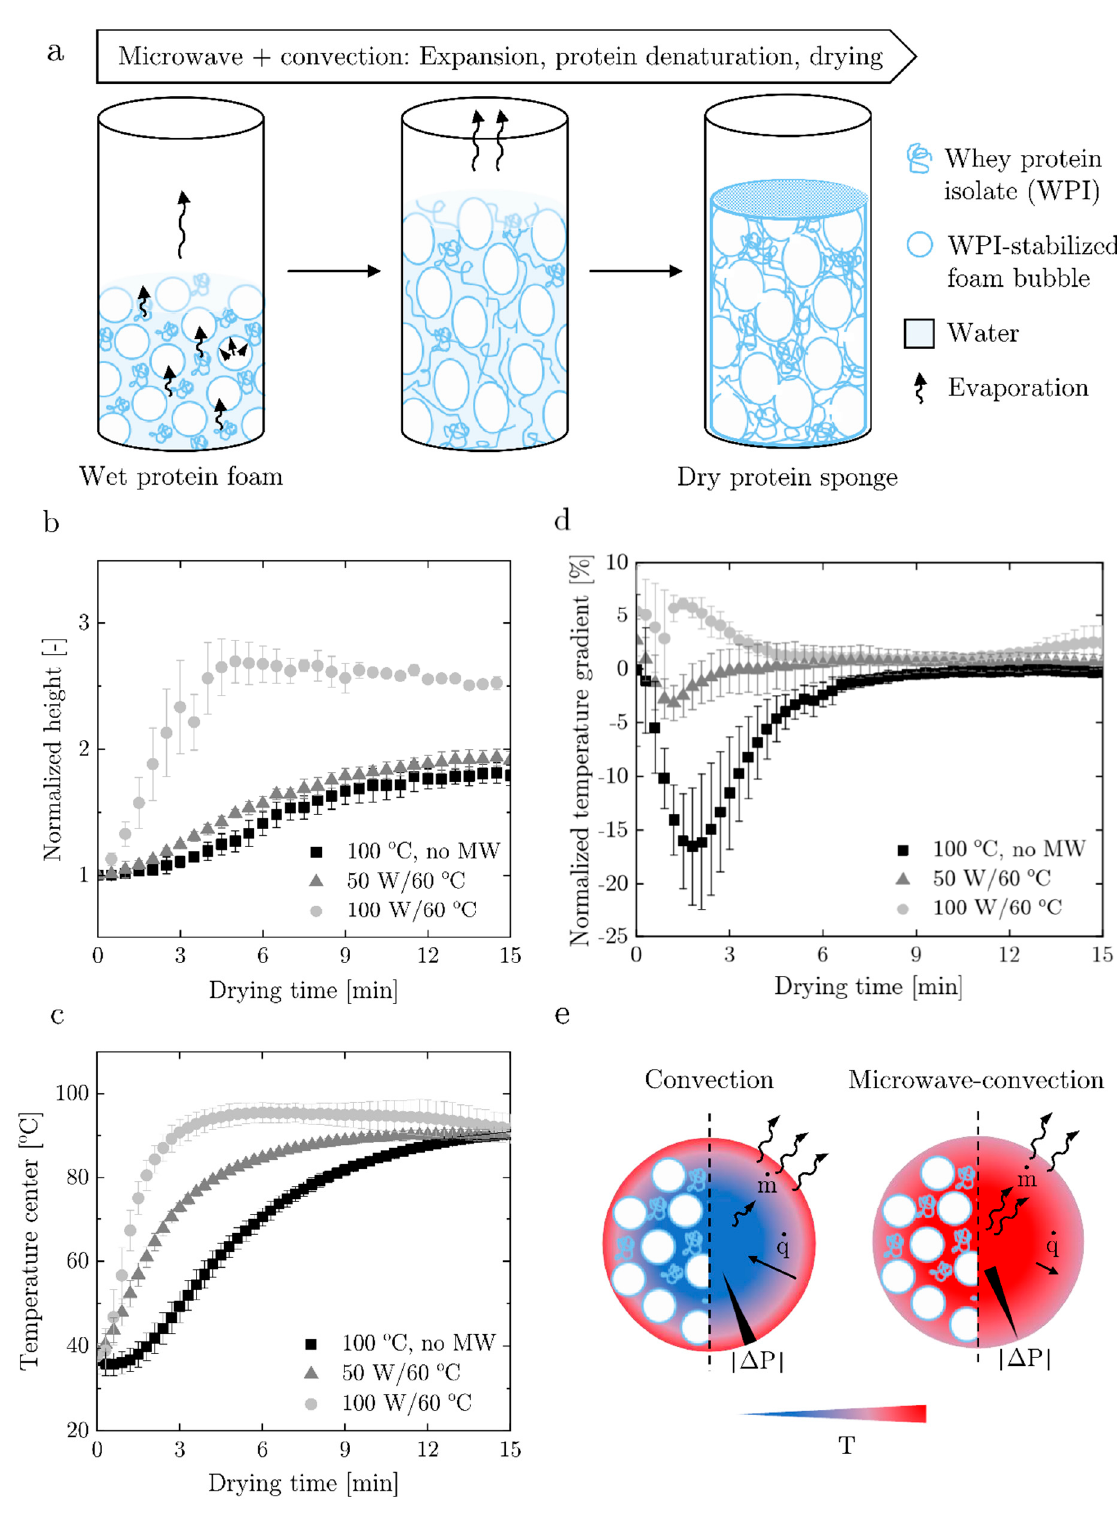
Figure 1. Microwave-convection drying of protein foam: ( a ) schematic illustration of the drying process to turn a wet protein foam based on whey protein isolate into a dry protein sponge; involving expansion, protein denaturation and drying induced by superimposed microwave and convection heating in an open top cylindrical mold. ( b ) Expansion kinetics at different drying conditions; ( c ) center temperature at different drying conditions; ( d ) normalized temperature gradient within the foam in radial direction at different drying conditions; and ( e ) schematic illustration of temperature distribution T, heat flux (q), water flux (m) and absolute pressure differences | Δ P| over the radial cross-section of the foam sample at the beginning of the drying process with and without superposition of microwaves.